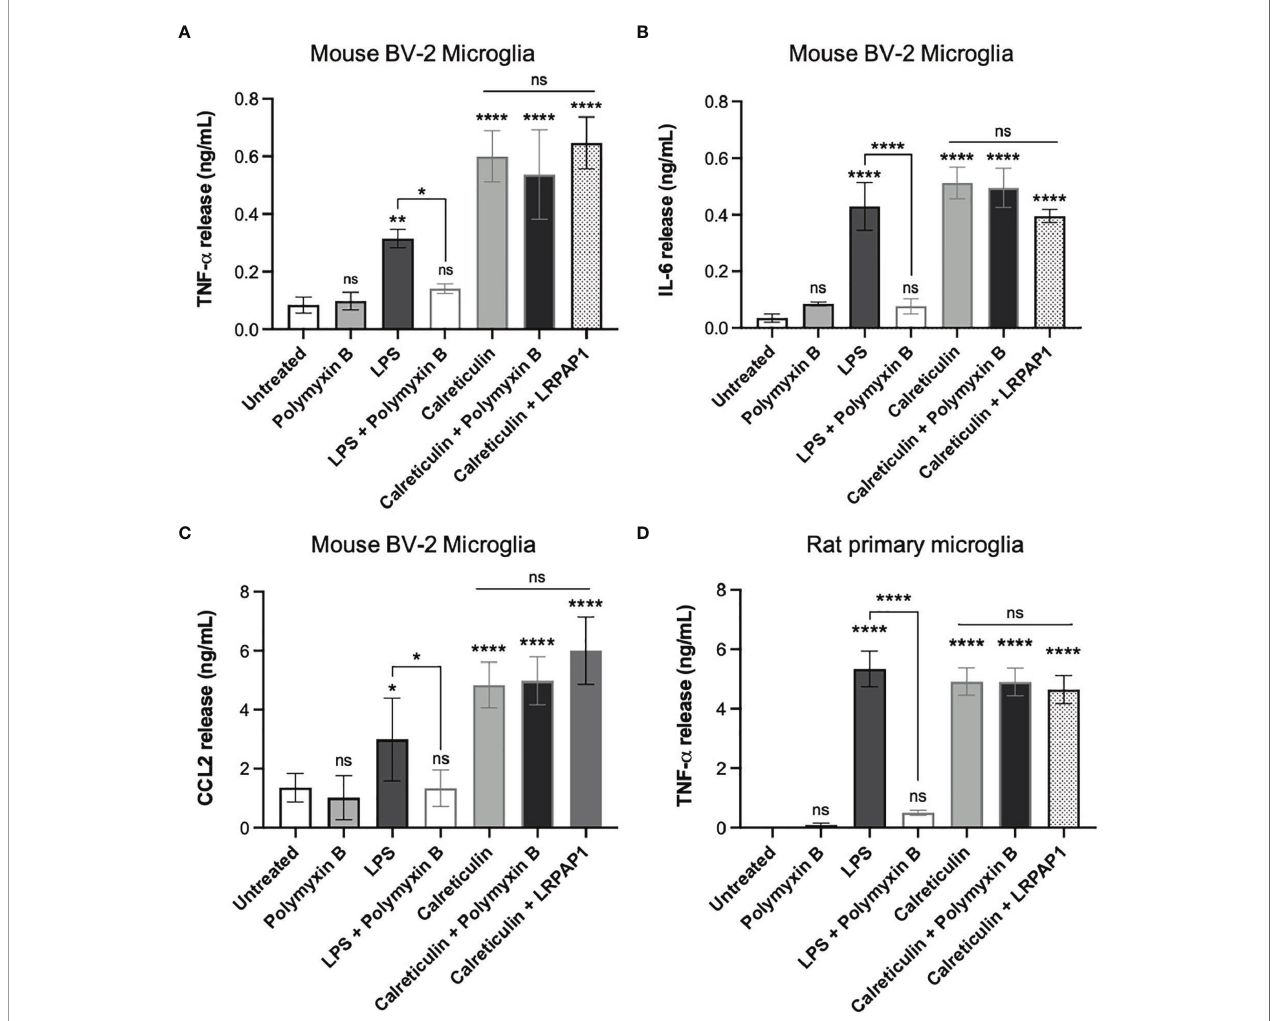
FIGURE 3 | Calreticulin induces cytokine and chemokine release from BV-2 and primary microglia independent of endotoxin and LRP1. BV-2 and rat primary microglia were treated with polymyxin B (10 U/mL), lipopolysaccharide (LPS, 100 ng/mL) ± polymyxin B, and calreticulin (170 nM) ± polymyxin B or LRPAP1 (100 nM) for 20 hours. Supernatants from treated BV-2 were assessed for (A) TNF- a , (B) IL-6 and (C) CCL2 by ELISA. (D) Supernatants of treated primary microglia were assessed for TNF- a by ELISA. Data presented as mean cytokine or chemokine release values, with error bars representing the SEM of at least 3 independent experiments. Statistical comparisons were made to the untreated control, or as illustrated by a comparison line, by one-way ANOVA. ns: p ≥ 0.05, *p<0.05, **p<0.01,